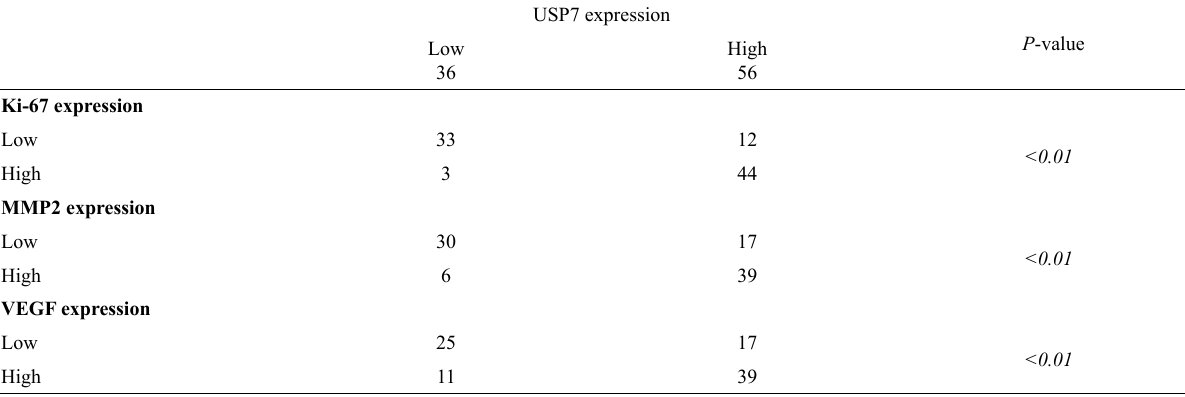
Table 2 – Correlation of USP7 with Ki-67, MMP2 and VEGF expression in OSCC cases.